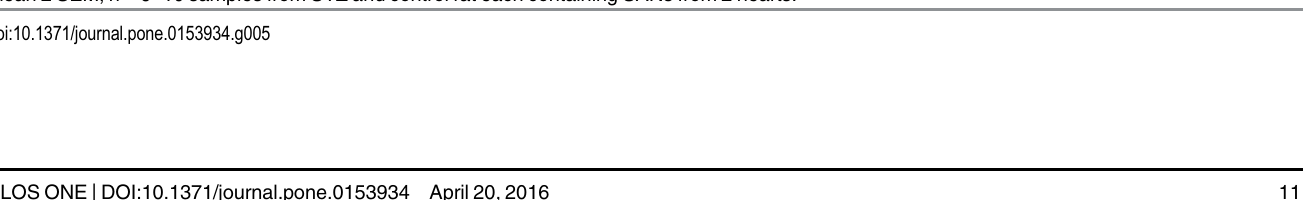
PLOS ONE | DOI:10.1371/journal.pone.0153934 April 20,